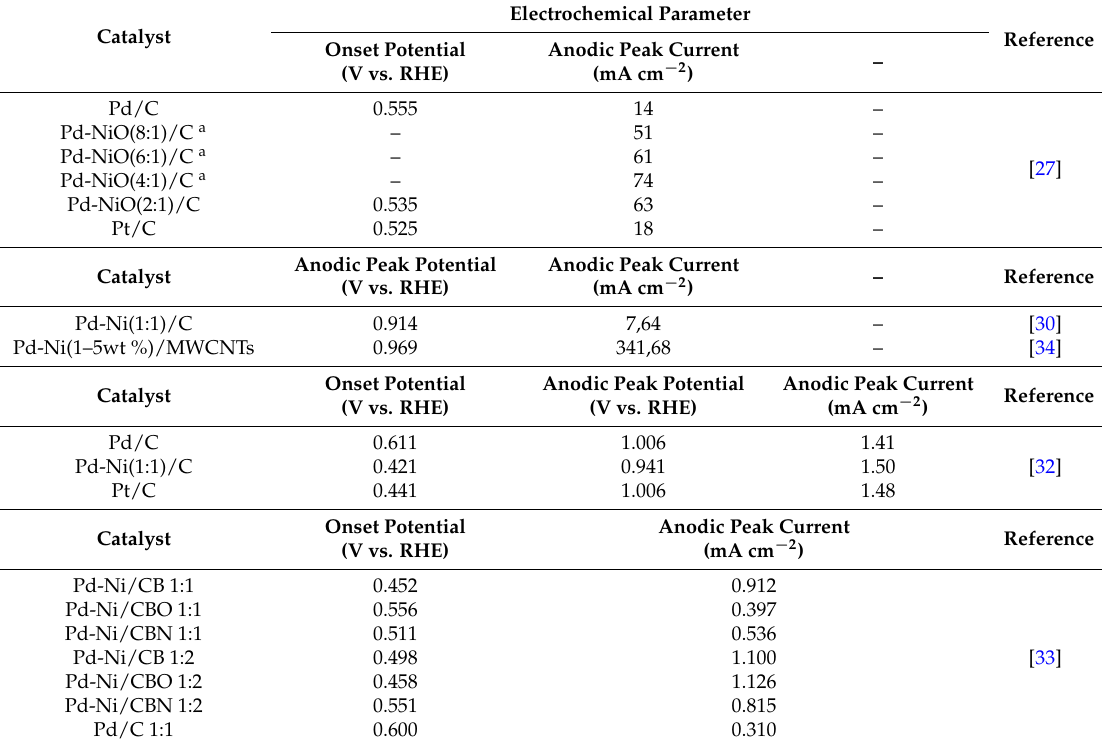
Table 3. Electrochemical properties of Pd-Ni catalysts supported on different carbon